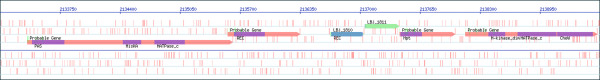
Leptospira borgpetersenii serovar Hardjo-bovis JB197 genome. Genomic context for a chromosomal region (2133100 – 2139600). Genes are represented in the six reading frames with initial data from the NCBI database (green genes with domains in blue) and the result of the P2CS analysis process (genes in light red with domains in purple). Red vertical lines represent stop codons and green lines represent potential start codons.